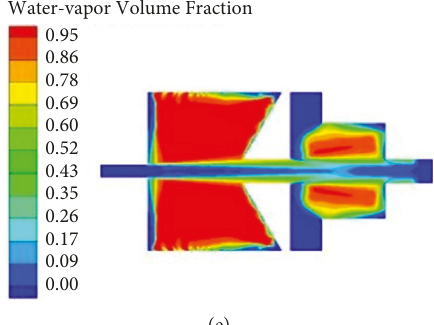
Figure 8: Cloud images of the water vapor phase volume fraction of dual-chamber self-excited oscillating pulsed nozzles. (a) Organ pipe, (b) Helmholtz, (c) organ pipe + organ pipe, (d) Helmholtz + Helmholtz, and (e) Helmholtz + organ pipe.